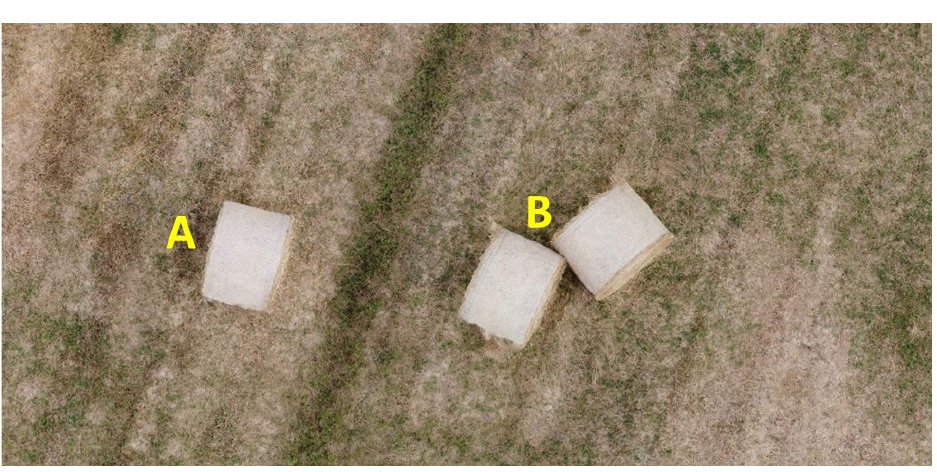
Figure 7. Target objects for the second experiment.